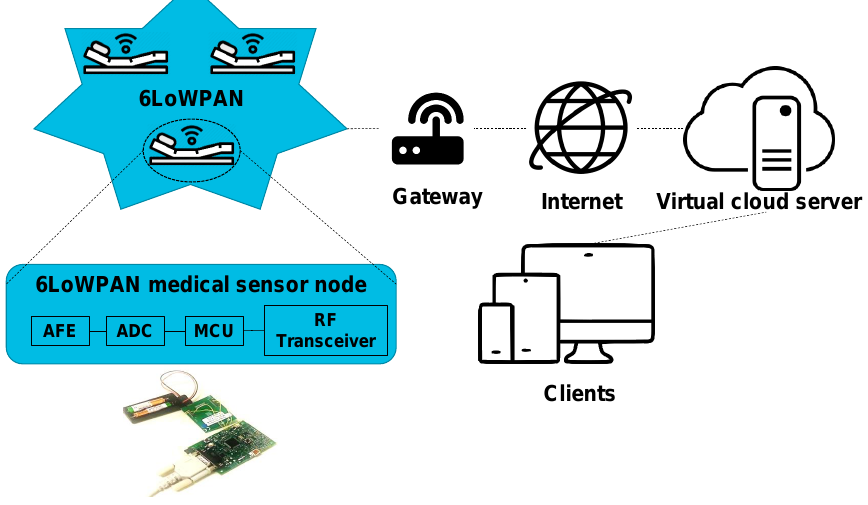
computing for healthcare applications [39].